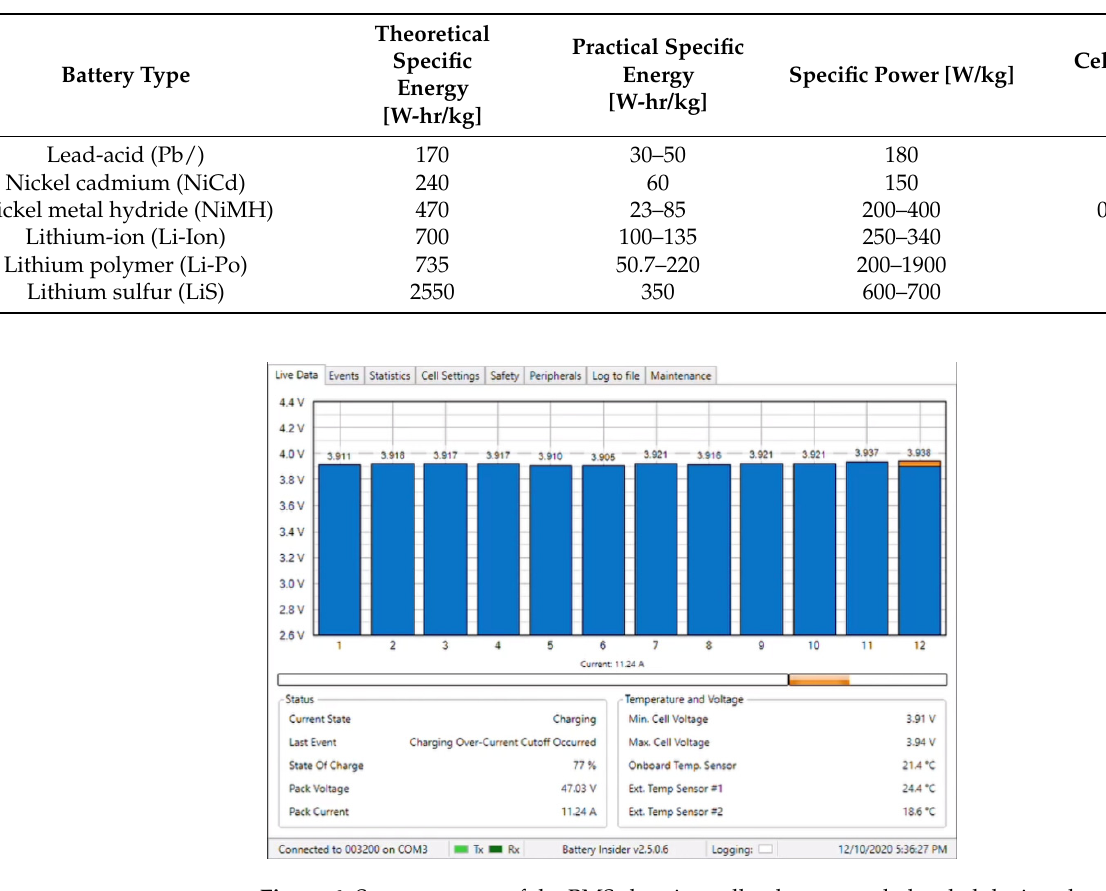
Table 2. Specific energy of different battery chemistries.